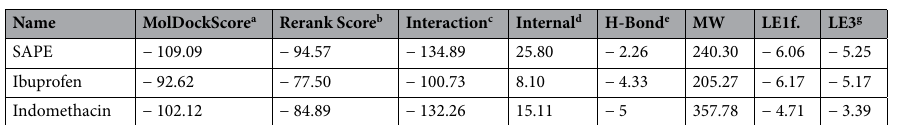
Table 1. Docking scores of the compounds docked against COX-2. a E Score = E inter + E intra , where E inter is the ligand–protein interaction energy and E intra is the internal energy of the ligand. b The rerank score is a linear combination of E-inter between the ligand and the protein, and E-intra of the ligand weighted by pre-defined coefficients (more negative means more stable). c The total interaction energy between the pose and the protein (kJ mol −1 ) (more negative means more stable). d The internal energy of the pose (the lesser the better). e Hydrogen bonding energy (kJ mol −1 ) (more negative means more stable). f Ligand Efficiency 1: MolDock Score divided by Heavy Atoms count (more negative means more stable). g Ligand Efficiency 3: Rerank Score divided by Heavy Atoms count (more negative means more